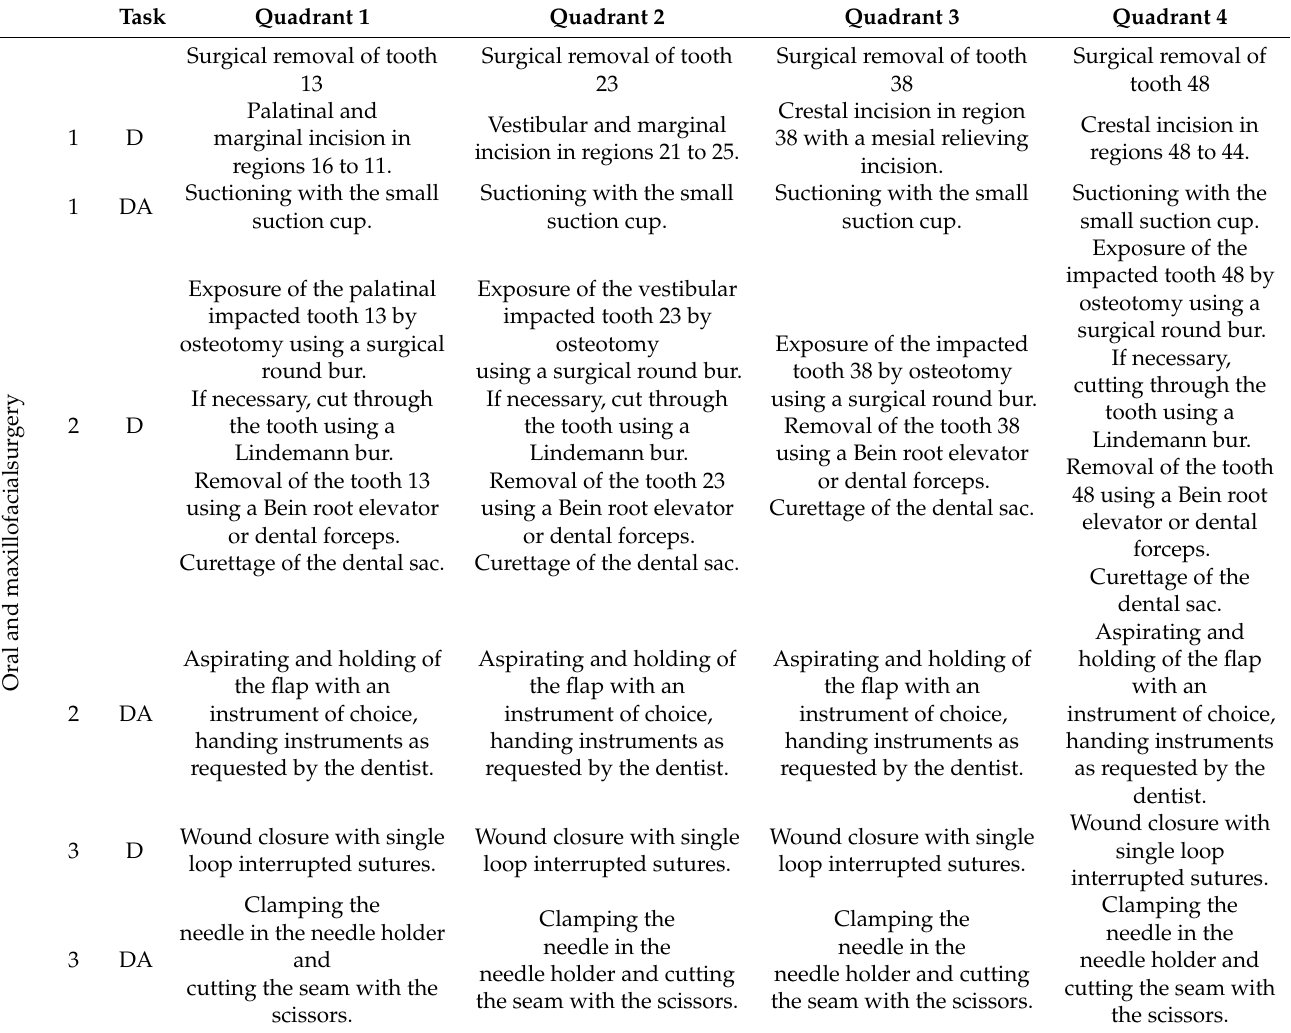
the seam with the scissors.